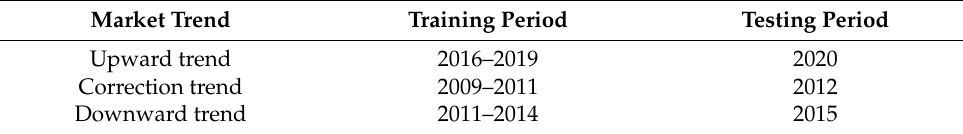
Table 10. Training and testing periods of three trends.